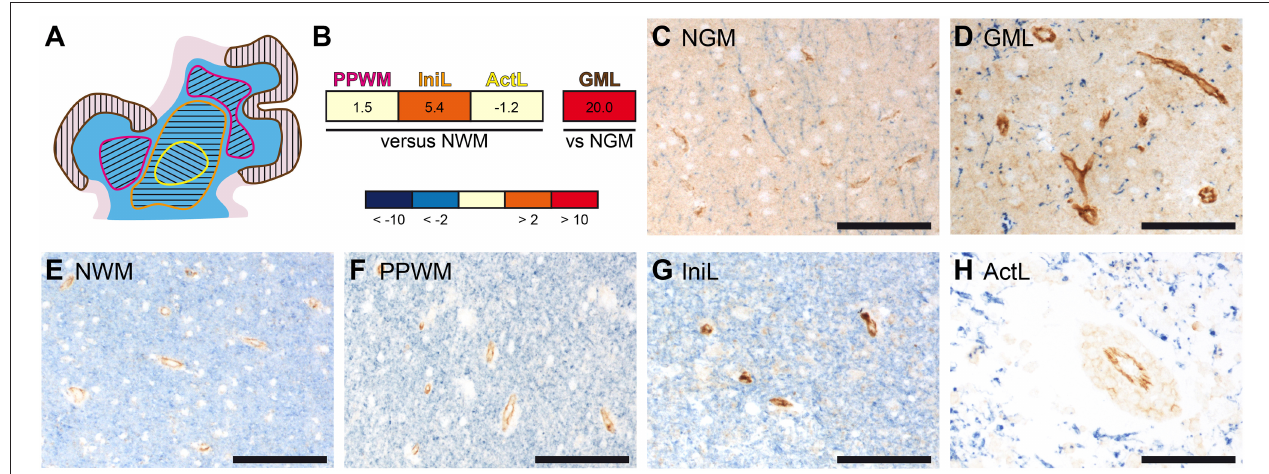
FIGURE 1 | Gene and protein expression of PECAM-1 is pronounced in initial white matter MS lesions and active cortical MS lesions. (A) Representative schematic overview of the different MS lesions included in the microarray analyses. The separately microdissected zones are encircled by differently colored lines: yellow, active demyelinating lesion; orange, initial (pre-phagocytic) lesion; pink, periplaque white matter; brown, active cortical gray matter lesion. White matter is depicted in blue; the cortical ribbon is depicted in rose. (B) Gene expression analysis in microdissected MS brain lesions. PECAM-1 expression in affected white matter areas ( n = 4 patients) was compared to normal white matter of healthy controls ( n = 4 subjects); PECAM-1 expression in active cortical gray matter MS lesions ( n = 3 patients) was compared to cortical areas isolated from healthy controls ( n = 3 subjects). Non-parametric analyses did not reach any significance levels (white matter: H (3) = 1.888, p = 0.6284; gray matter: U = 0.000, z = − 1.964, p = 0.100, r = − 0.802). PPWM, periplaque white matter; IniL, initial (pre-phagocytic) lesions; ActL, active demyelinating lesions; NWM, normal white matter; GML: gray matter lesion; NGM: normal gray matter (C–H) Immunohistochemical double-labeling for PECAM-1 (brown) and the myelin component proteolipid protein (PLP; blue) of normal gray matter of control (C) , active cortical gray matter MS lesion (D) , normal white matter of control (E) , periplaque white matter (F) , initial (pre-active) MS lesions (G) and active MS lesions (H) . Representative pictures are shown. Scale bars, 100 µ m.